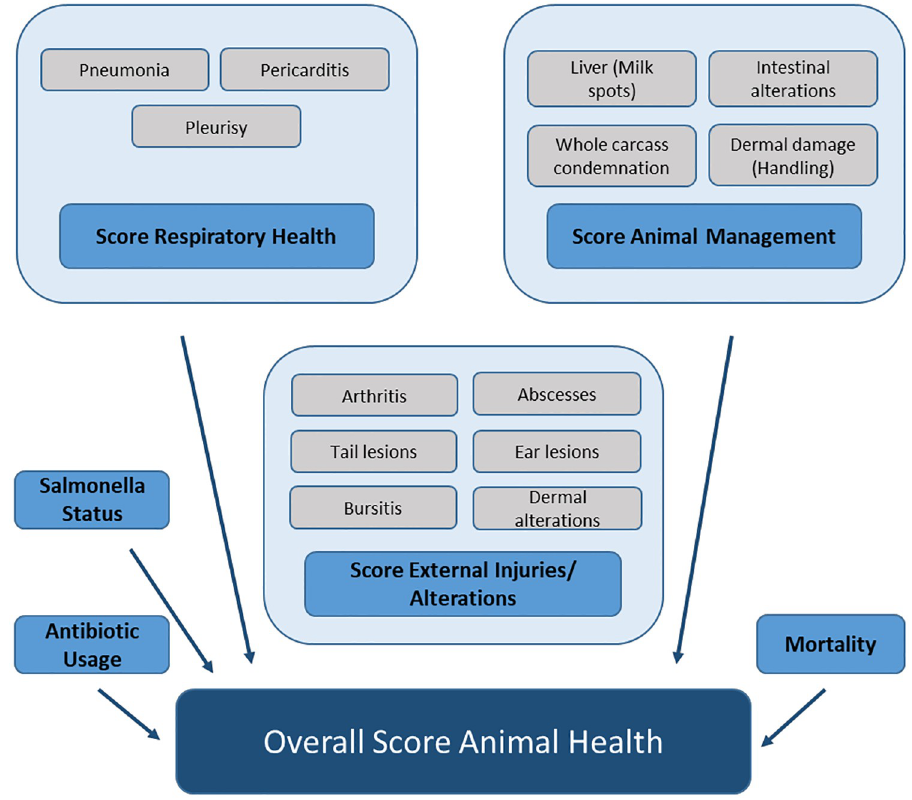
Fig 1. Indicators and scores included to describe health at the farm